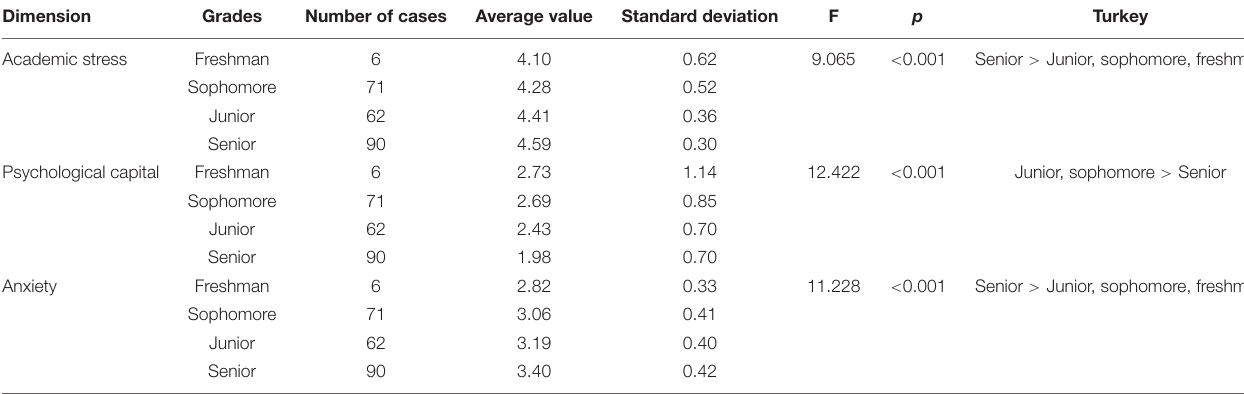
TABLE 5 | Difference test results of academic stress, psychological capital, and anxiety in different grades. Dimension Grades